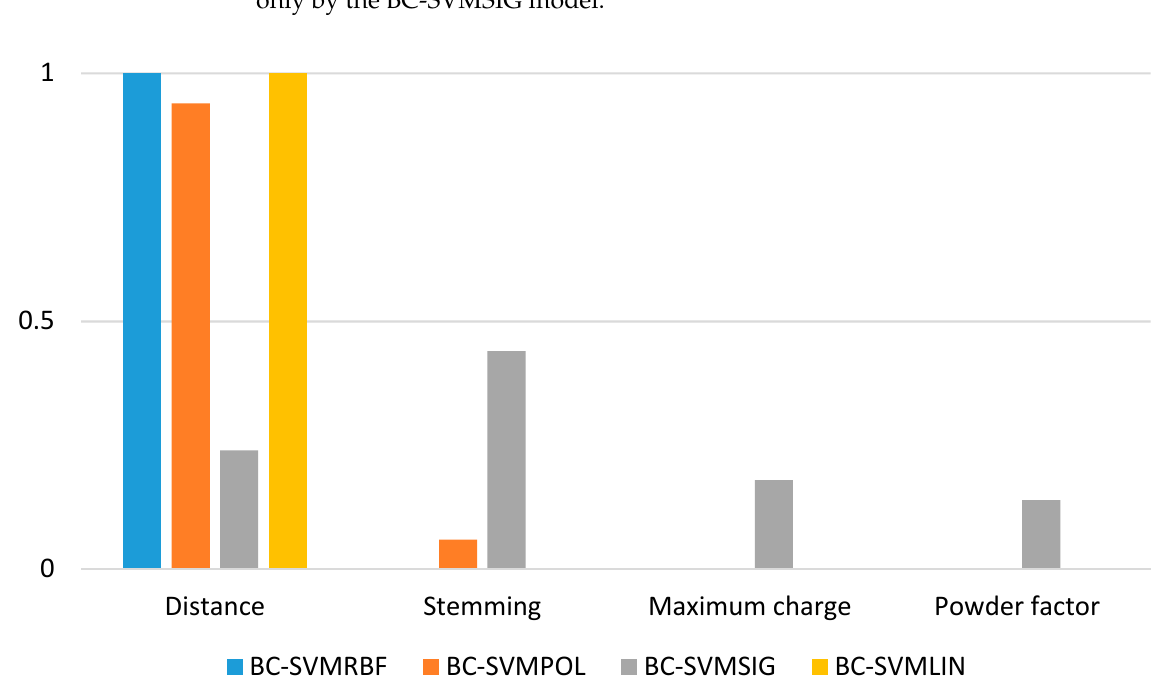
Figure 9. Input variable importance for the analysis of PPV.